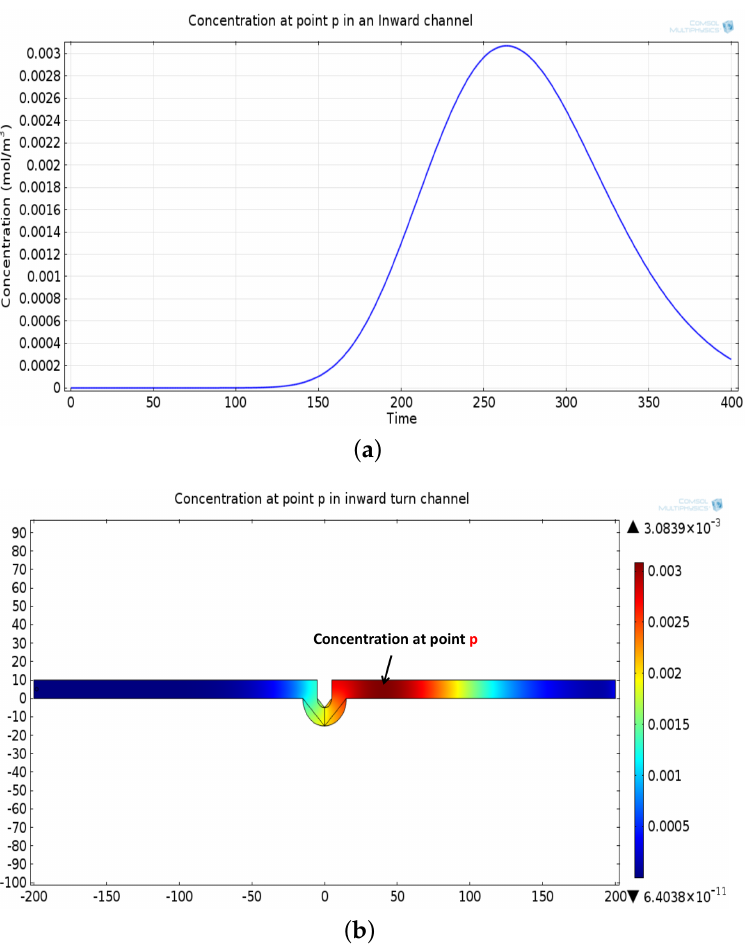
Figure 9. ( a ) Recovered concentration signal at point p , after passing through the outlet of inward turn. ( b ) Two-dimensional surface plot showing concentration profile at point p in a inward turn